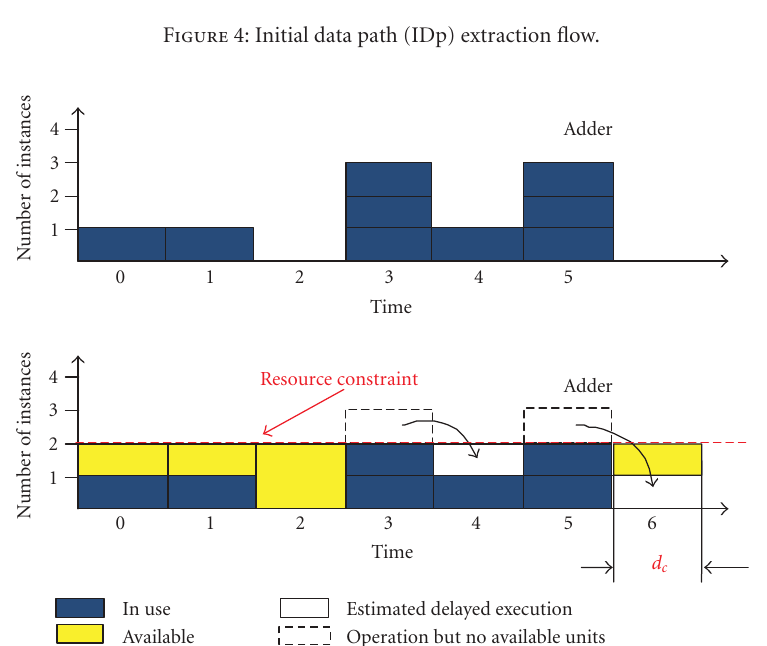
Figure 4: Initial data path (IDp) extraction flow.